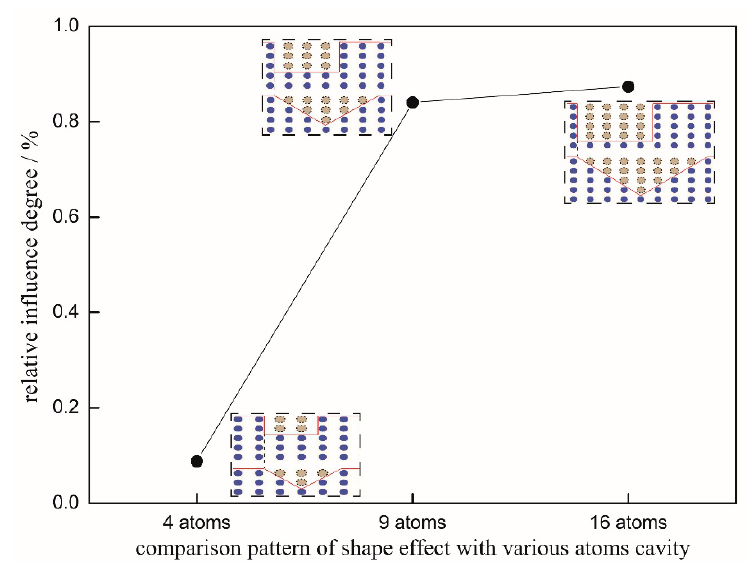
Figure 3. Relative influence degree on nanohardness between thin films with triangular defect and rectangular defect.